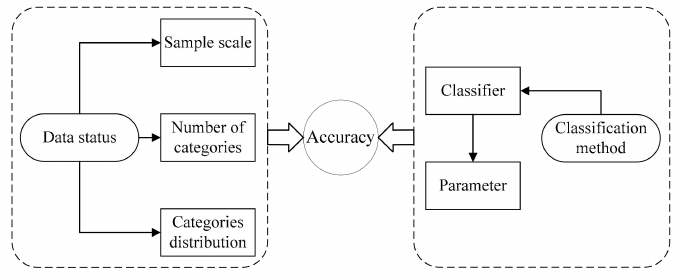
Figure 5. Factors influencing classification accuracy.